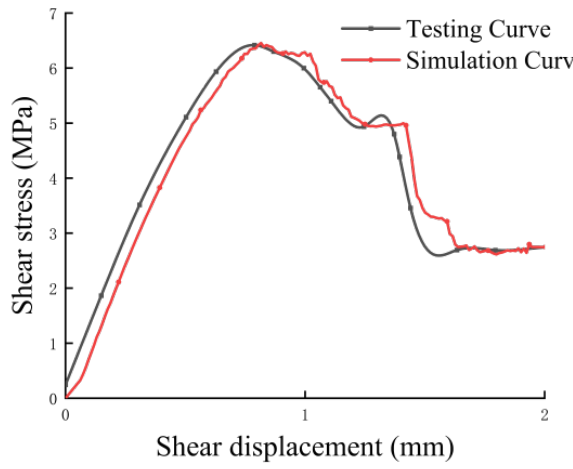
Figure 10. Simulation diagram of specimen with 40° undulating angle.